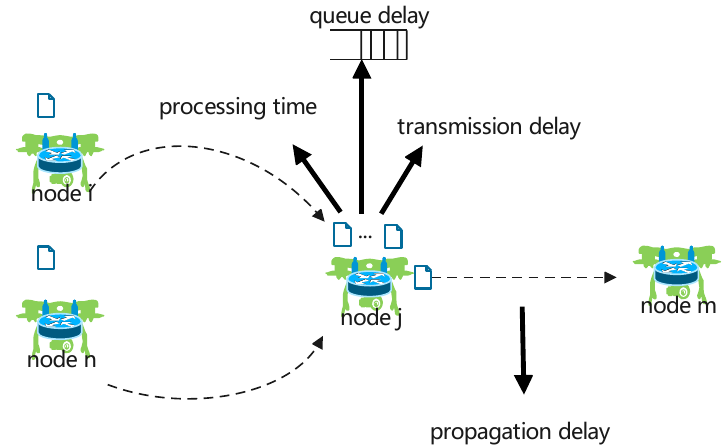
Figure 1. Composition of the point-to-point delay between two